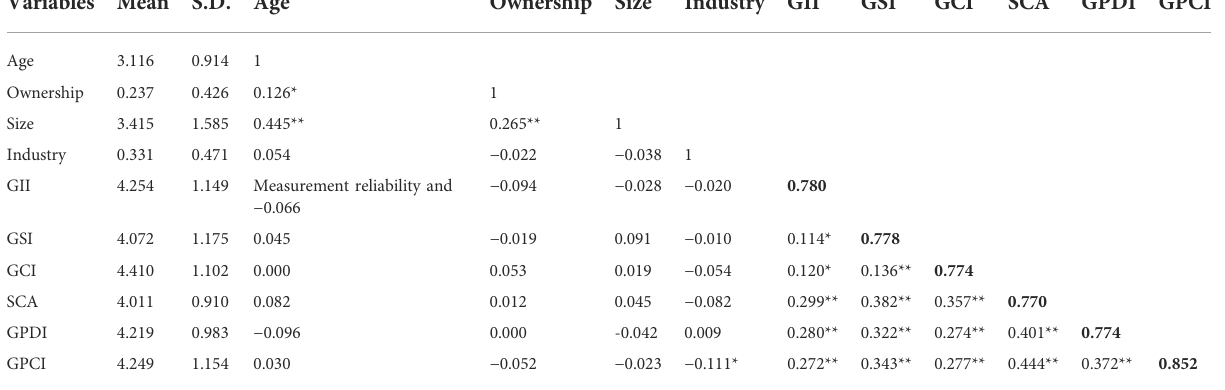
TABLE 3 Summary and correlation of variables. Variables Mean S.D. Age